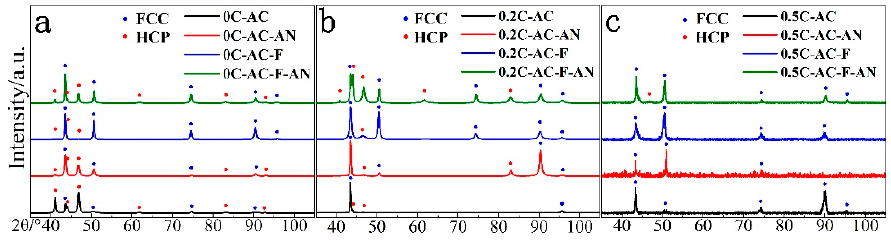
Figure 7. XRD patterns of the specimens with different carbon contents under different heat- treatment states. ( a ) with 0% carbon content; ( b ) with 0.2% carbon content; ( c ) with 0.5% carbon